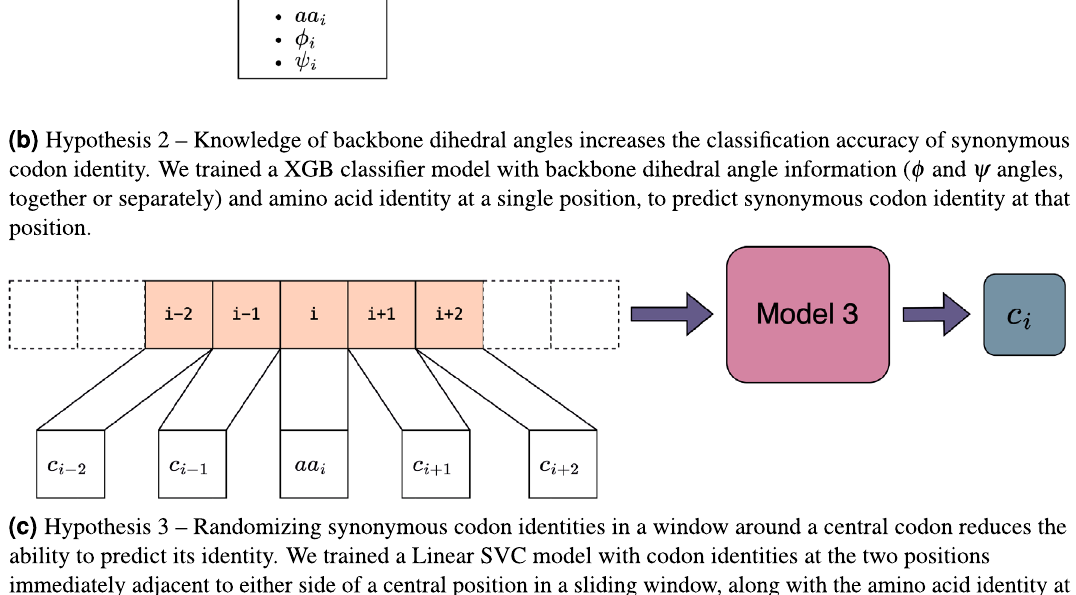
Figure 1. Schematic of model inputs and outputs for each hypothesis. Codon is indicated by c and amino acid is indicated by aa . Orange shading highlights the positions used as inputs. Only windows where all five positions have the same DSSP annotation were used and only H and E were considered, separately, in this